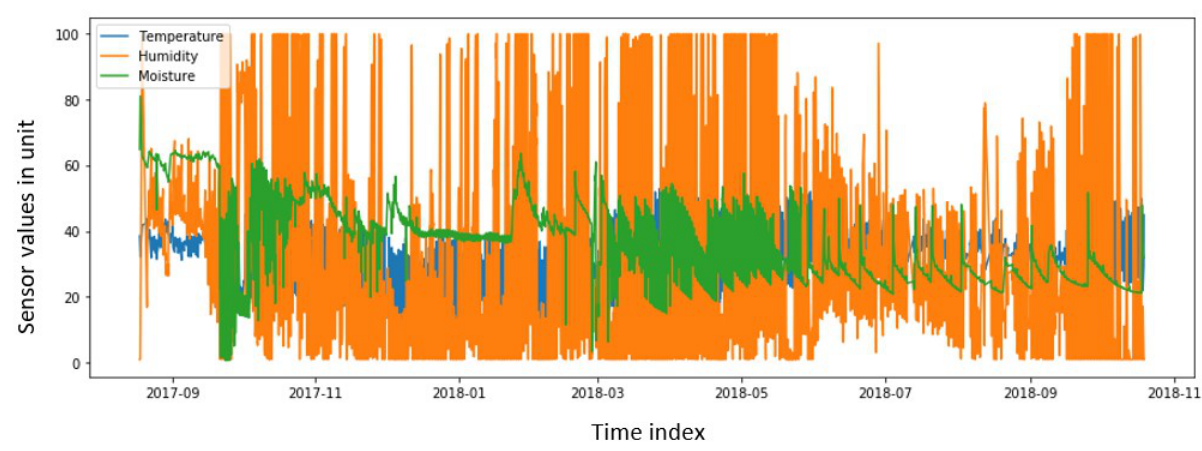
Figure 2. Plot of targeted variables (Temperature in ◦ C, humidity (H) and soil